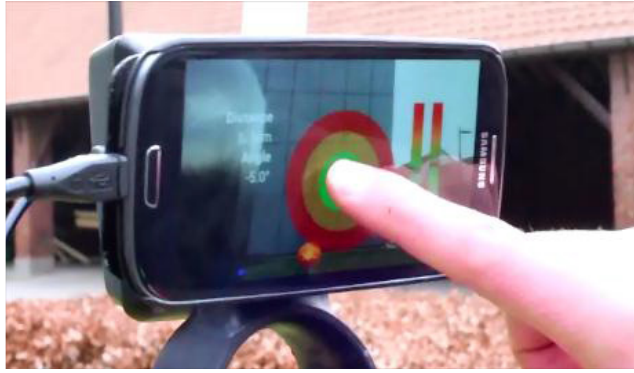
Figure 6. Spike-based target selection with ArcAid app.